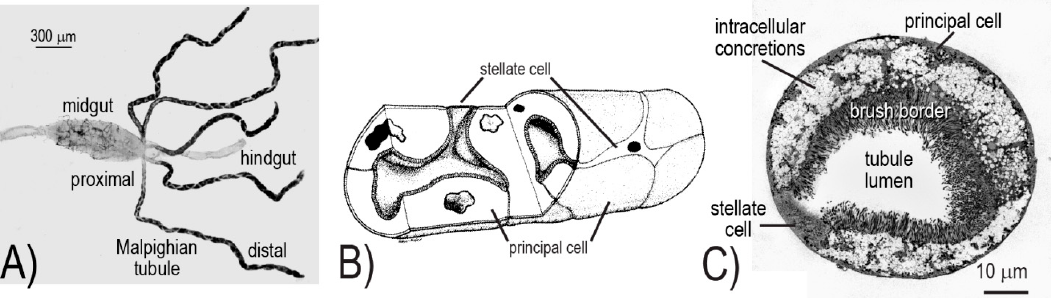
Figure 1 . Anatomy and morphology of mosquito Malpighian tubules. ( A ) Isolated alimentary canal of an adult female mosquito ( Aedes aegypti ). The five Malpighian tubules connect to the alimentary canal at the junction of the midgut and hindgut. ( B ) Schematic of the distal end of a Malpighian tubule showing the arrangement of the principal and stellate cells. ( C ) Transverse section of a Malpighian tubule visualized via transmission electron microscopy. The principal cell contains a luminal brush border that is rich with mitochondria; the cell curls upon itself to form the tubule lumen. A stellate cell is also apparent. Panels A and C are from [8] with permission; panel B is from [11] with permission.